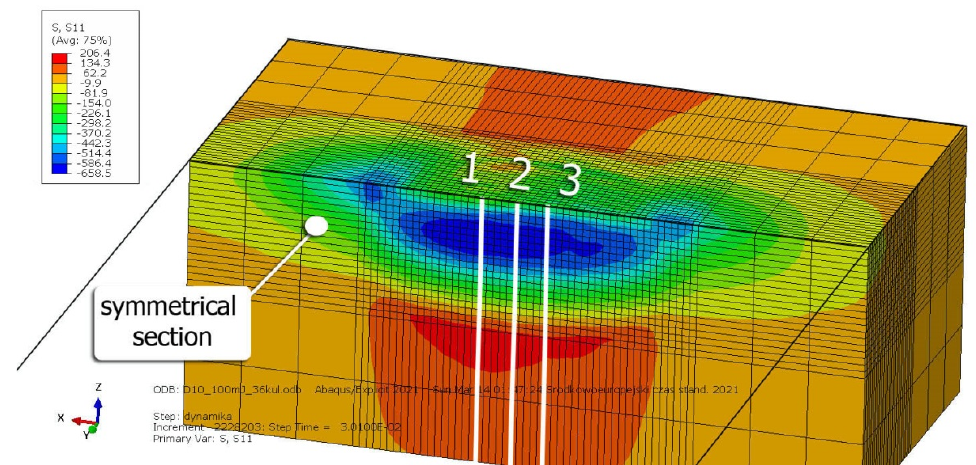
Figure 8. Method of determination the averaged S11 stress distribution based on three paths.